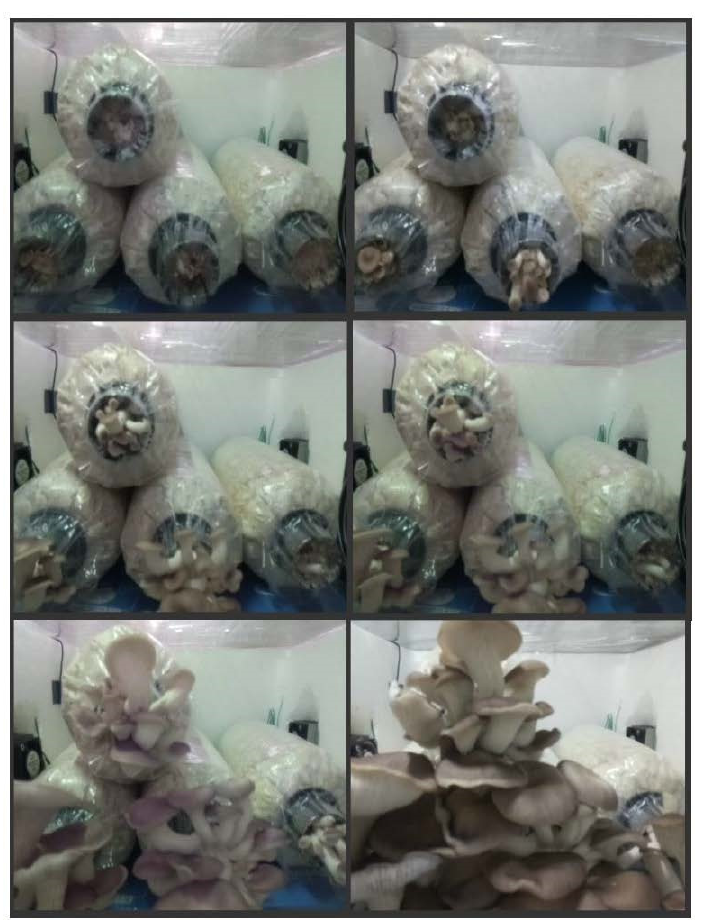
Figure 9. The growth of the grey oyster mushrooms monitored by the camera. From left to right and from top to bottom for the stage of increasing growth stage.